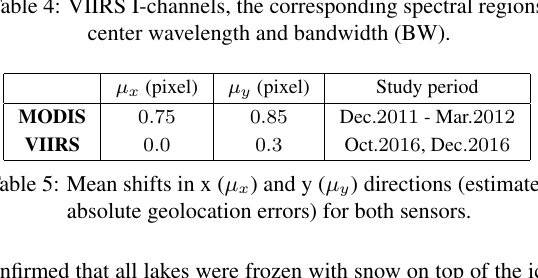
above 32767 . For all other images, cloudy and invalid pixels are masked out prior to analysis. Cloud detection performance can vary from one sensor to another. Separate cloud-masks are pro- duced for MODIS and VIIRS. Snow/cloud confusion and large view angles can result in considerable over-estimation of clouds and ice (Kraatz et al., 2017). This recent study also reported that there are substantial differences between the MODIS and VIIRS cloud-mask products, especially in the presence of ice. In addi- tion, owing to the fact that the VIIRS and MODIS acquisitions happen at different times of day, the clouds may not be in the same place during the MODIS and VIIRS overpasses, and thus can not be directly